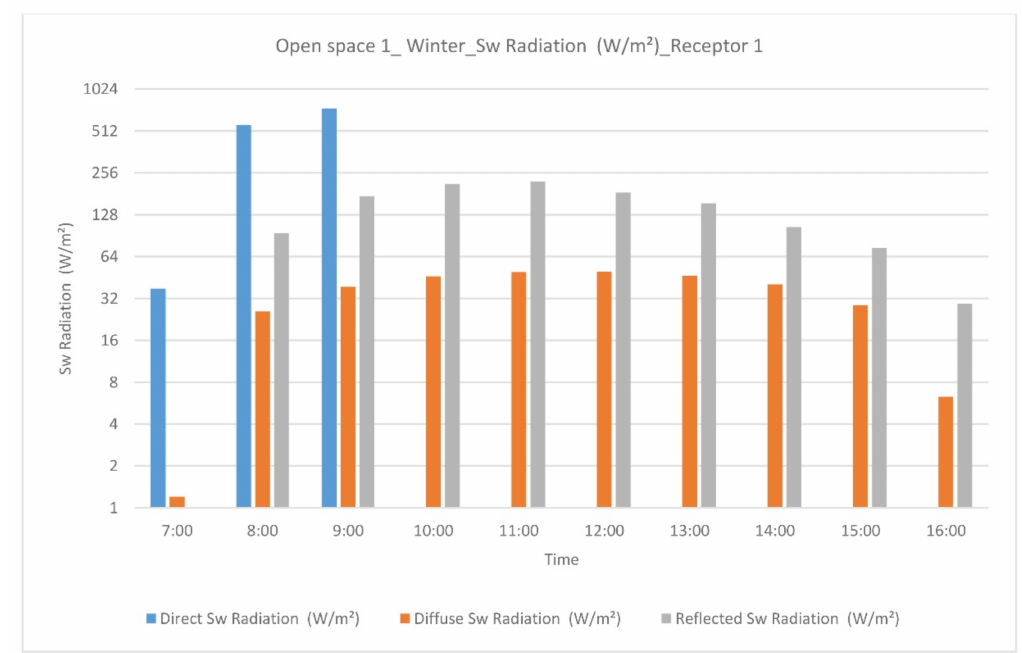
Figure A2. Open space 1 solar radiation in winter at receptor